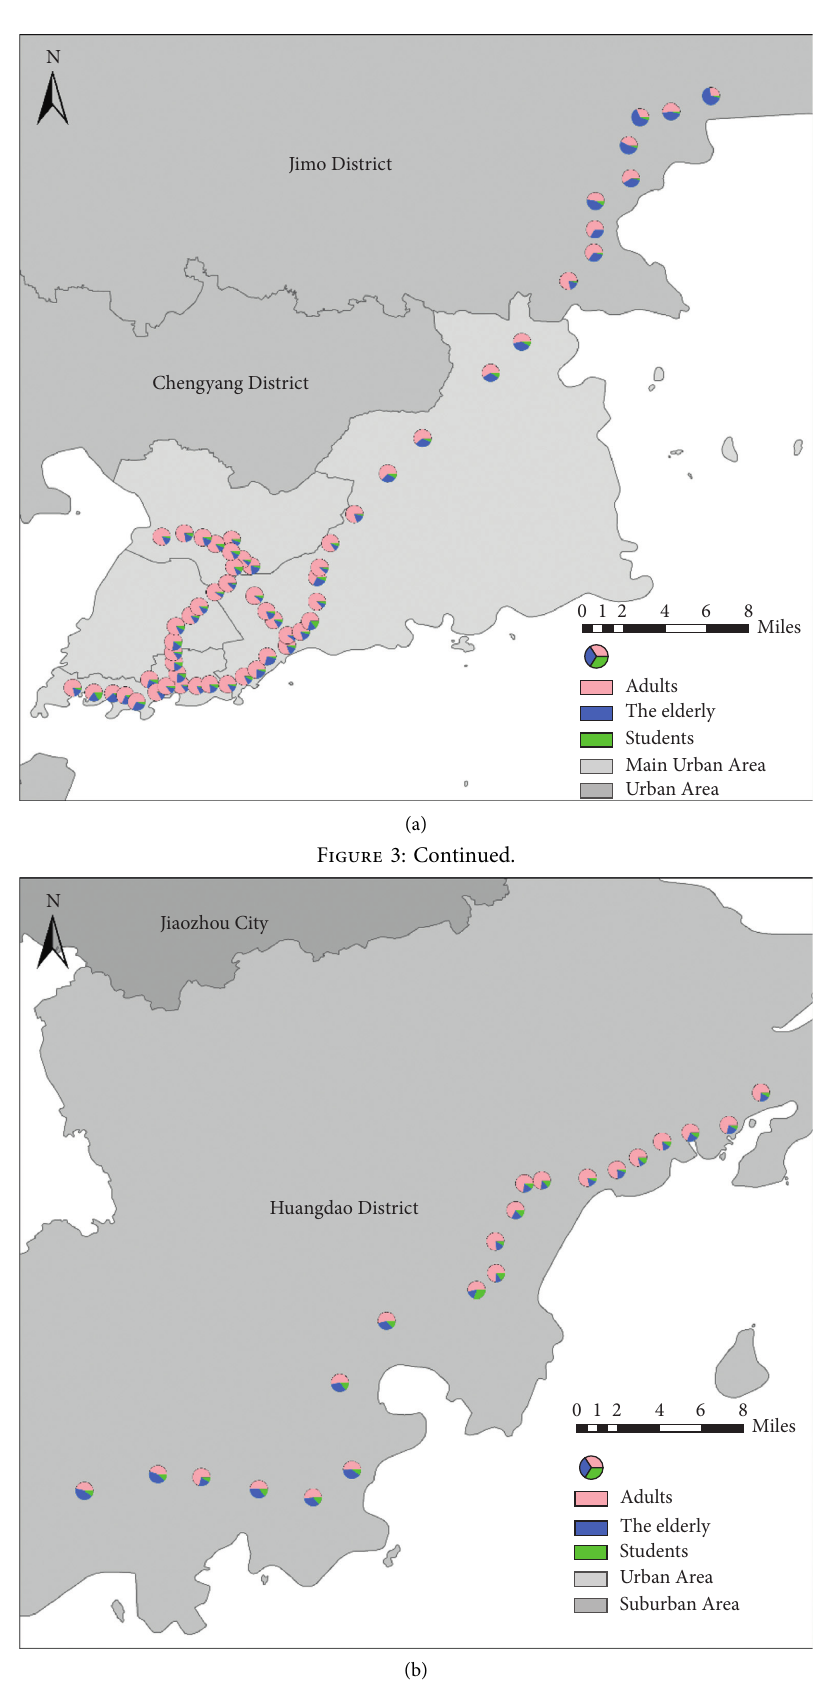
Figure 3: Station-level metro ridership composition of (a) east area and (station-level metro ridership composition of east area.) and (b) west area (station-level metro ridership composition of west